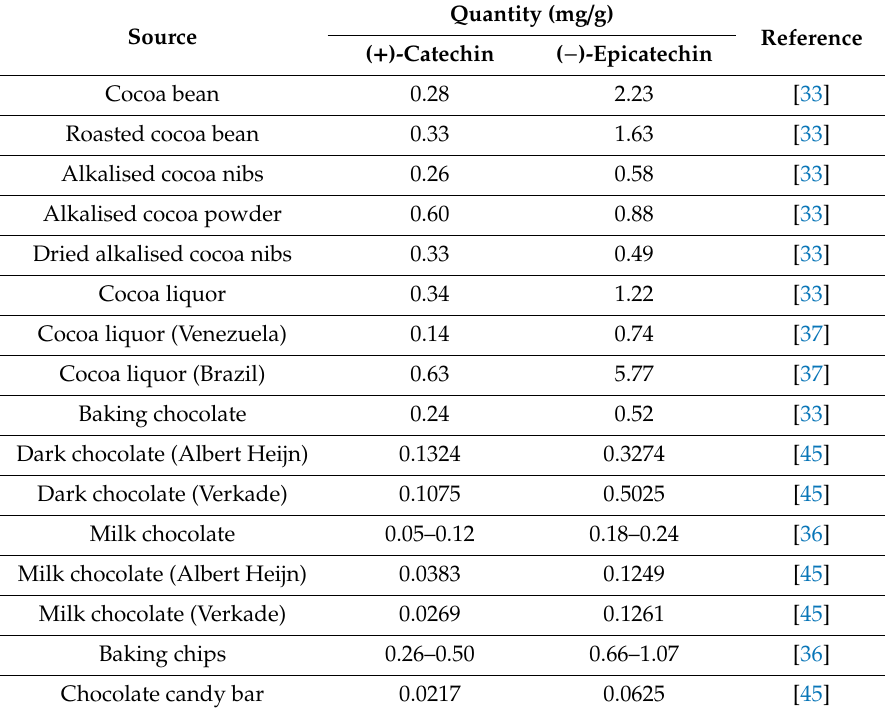
Table 2. ( + )-catechin and ( − )-epicatechin content of cocoa bean and its